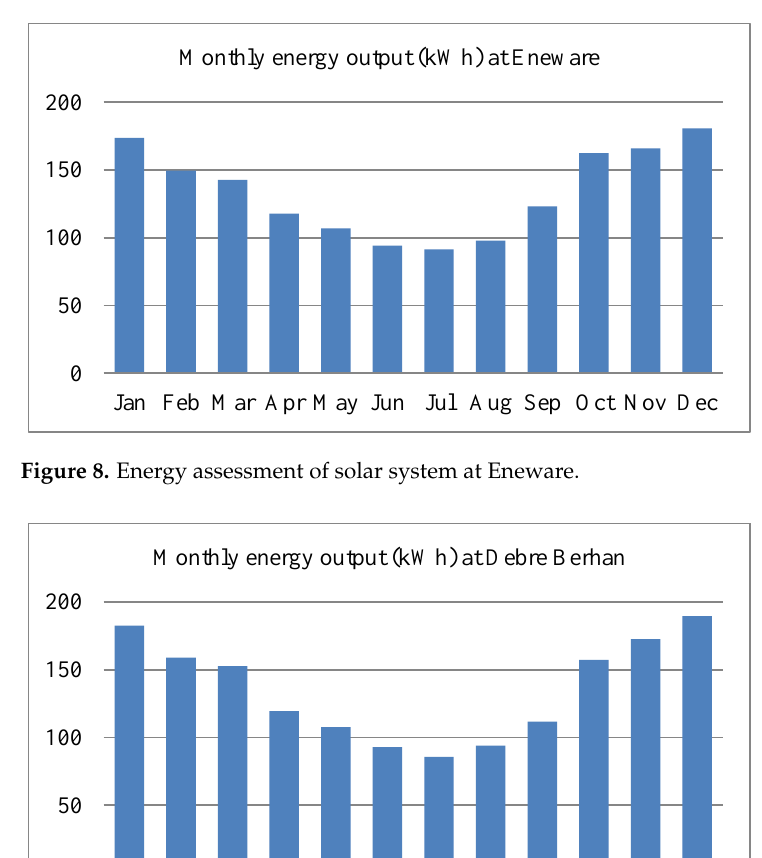
Figure 10. Energy assessment of solar system at Alem Ketema.